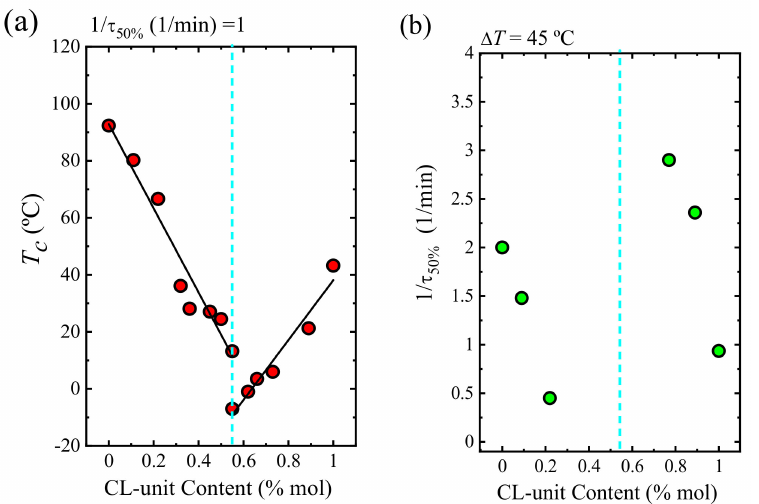
Figure 13. ( a ) T c values as a function of CL-unit content at a constant rate (1/ τ 50% = 1 1/min). ( b ) Inverse of half-crystallization time (1/ τ 50% ) as a function of the CL-unit content at a constant degree of supercooling ( ∆ T = 45 ◦ C). Data reported in ref. [38]. The K gG values were obtained by applying the Lauritzen-Hoffman theory, and are proportional to the energy barrier for crystallization. Figure 14 plots both K g values as a function of the CL-unit molar content. The K gG values are obtained from PLOM studies and are related to the energy barrier for spherulitic growth, and K g τ values are obtained from DSC studies and are related to the energy barrier for both primary nucleation and spherulitic growth. As expected K g τ exhibit larger values (as they include both nucleation and growth) than K gG values which depend on growth only.